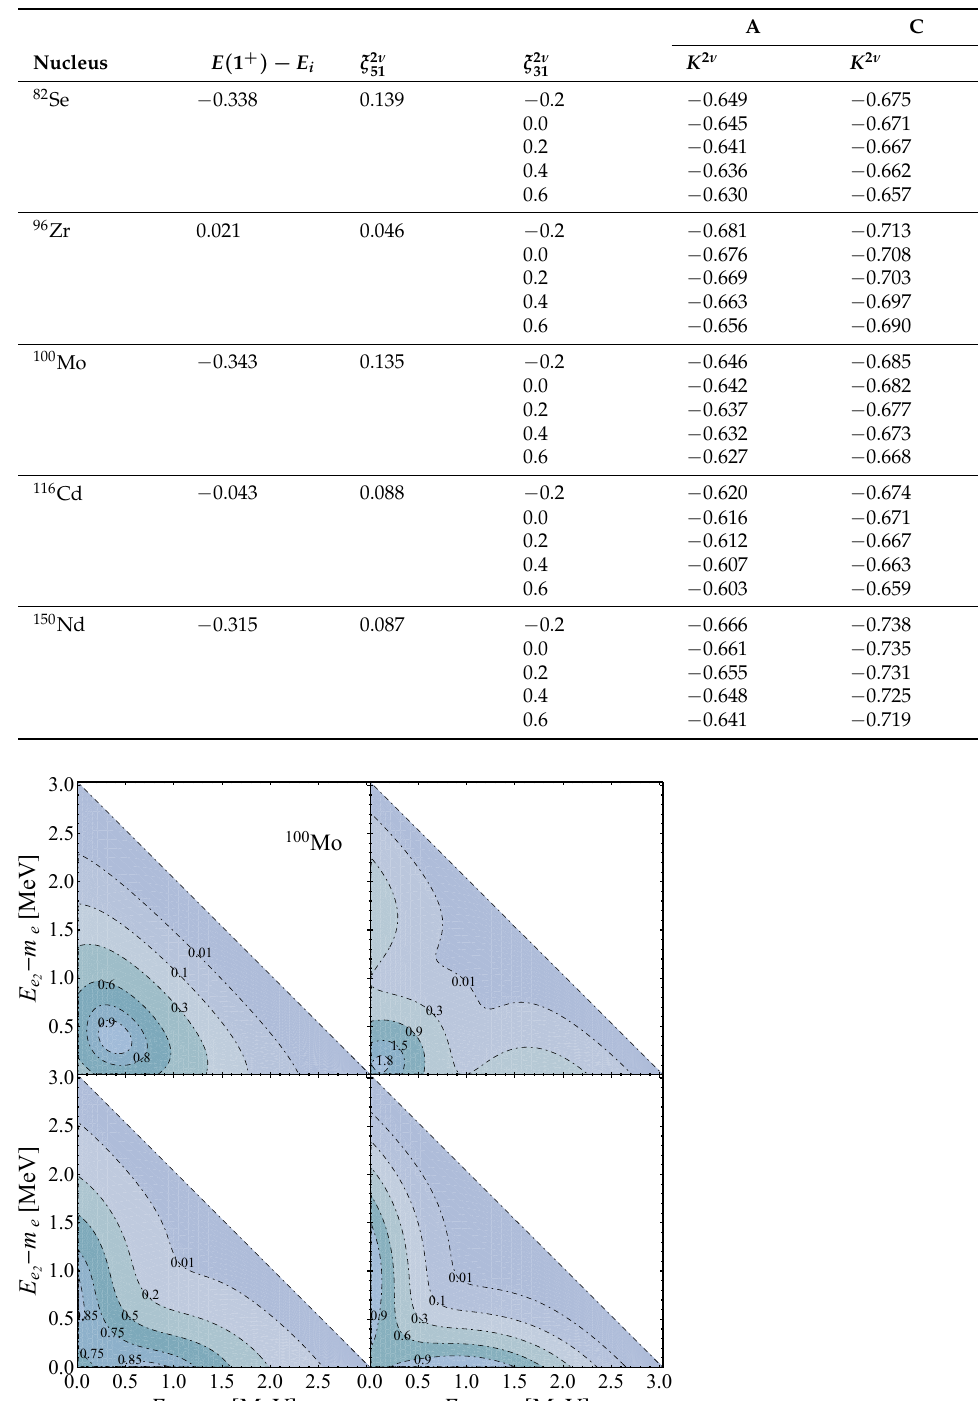
Table 3. The values of the angular correlation coefficient for different values of ξ 2 ν the approximation scheme A and C for the relativistic wave function of the emitted electrons. For each nuclei, we display the energy difference E ( 1 + ) − E i in MeV, necessary to calculate ξ 2 ν Equation (27).